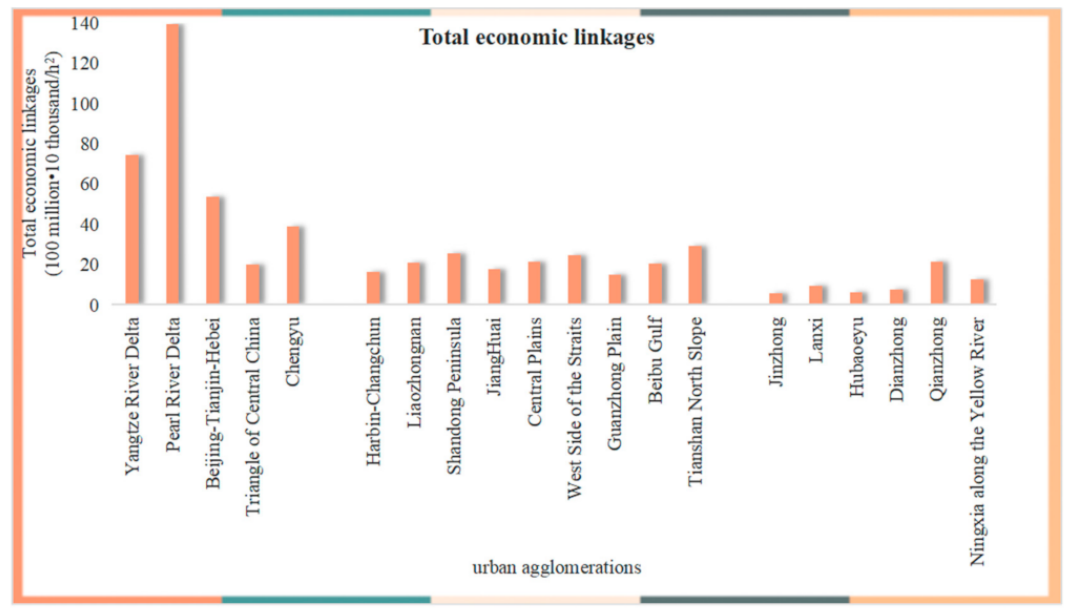
Figure 10. Total economic connection in 20 urban